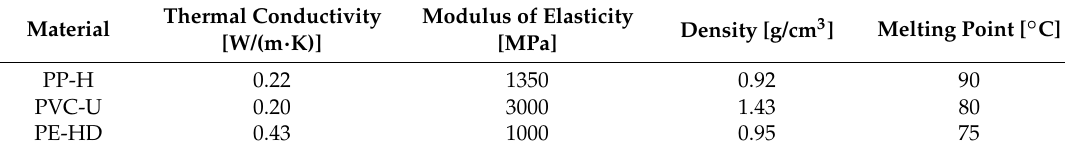
Table 3. Parameters of selected plastics.